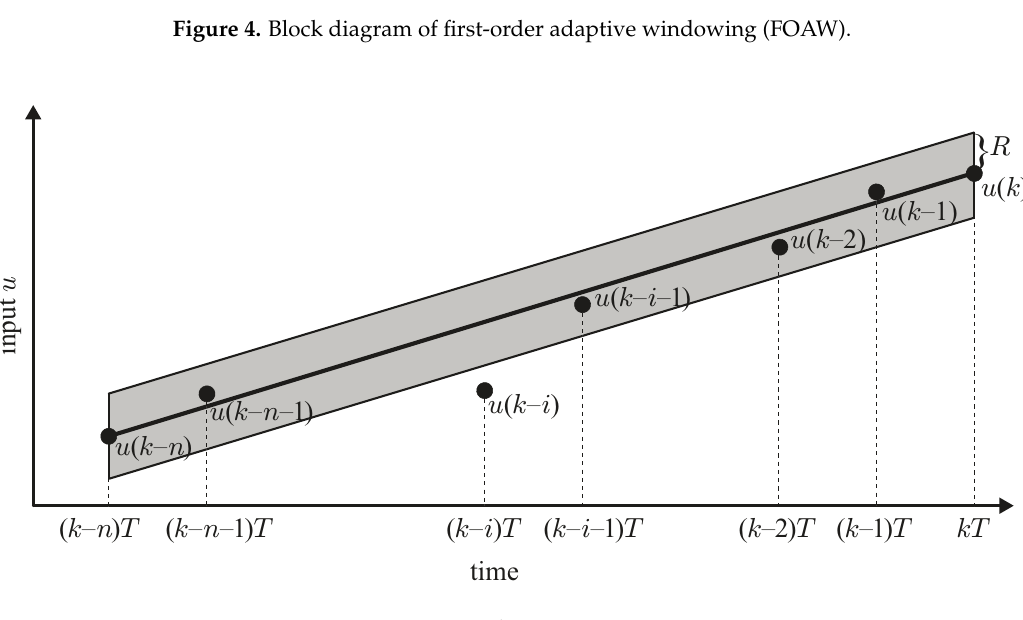
Figure 5. Windowing in